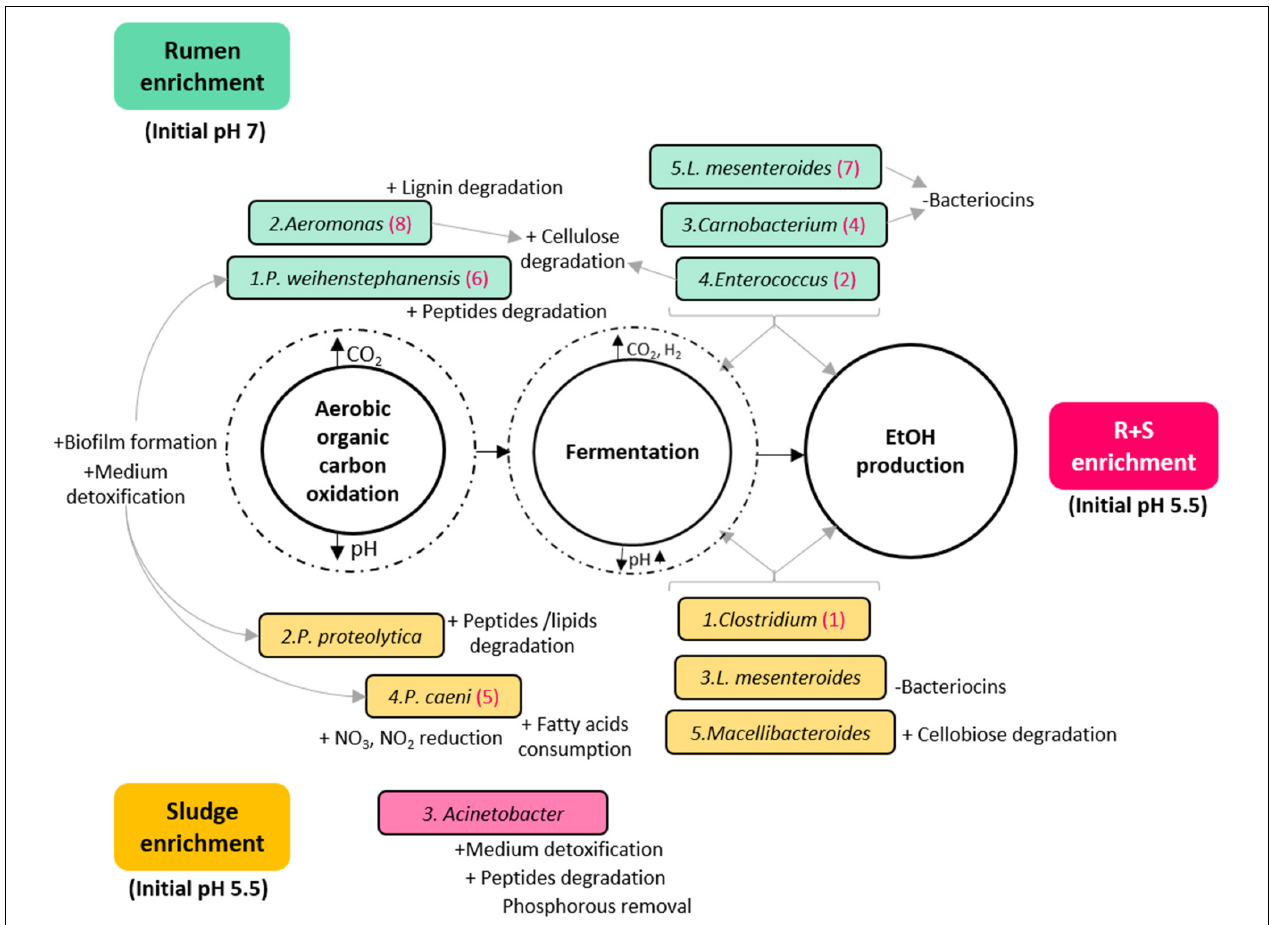
FIGURE 5 | Diagram of the putative functions of the dominant OTUs enriched from the different inocula under study. Turquoise rectangles: rumen enriched. Yellow rectangles: sludge enriched. Pink rectangle: R + S enriched. The numbers before the species name indicate in hierarchical order their contribution to the total relative abundance of their community. Numbers in brackets after the species name, signal OTUs also enriched in the R + S community in hierarchical order of contribution to the total relative abundance for this community. ± symbols before specific OTUs putative functions indicate an activity possibly benefiting ( + ) or damaging ( − ) the